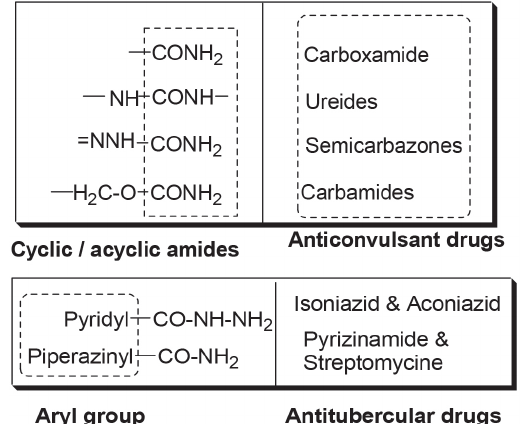
FIGURE 2 - Concept of pyridazinones as anticonvulsants and as anti-TB